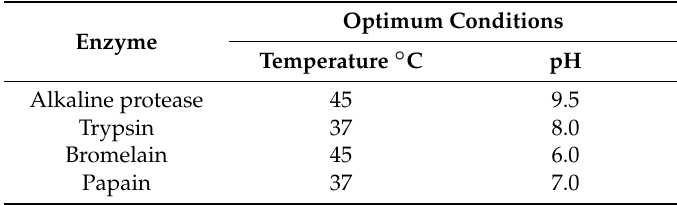
Table 1. Optimum conditions of enzymatic hydrolysis for various